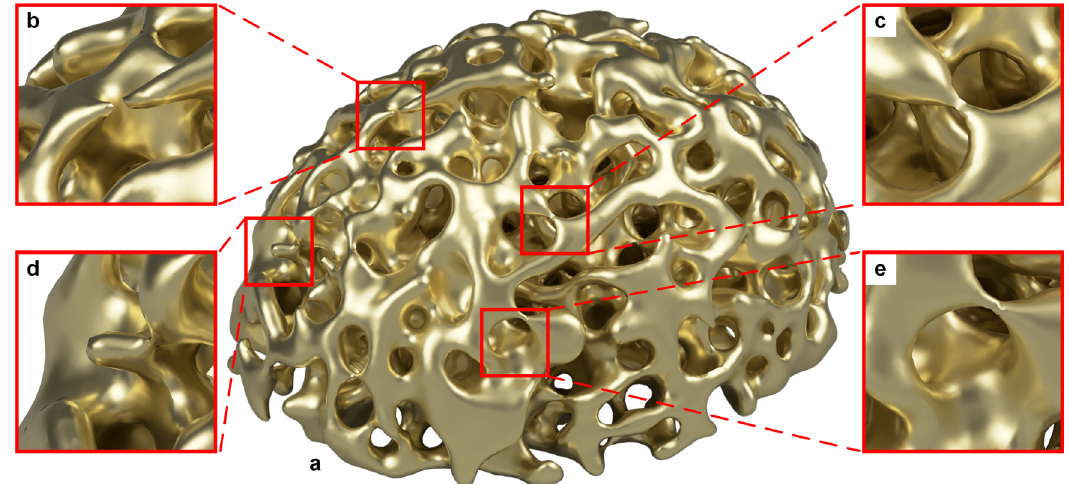
Fig. 5 Rendered images of characteristic geometric features of gold nanosponges. a simulated phase fi eld sponge S f ,2 ; b open ligament; c ligament; d dead-end ligament; e irregular